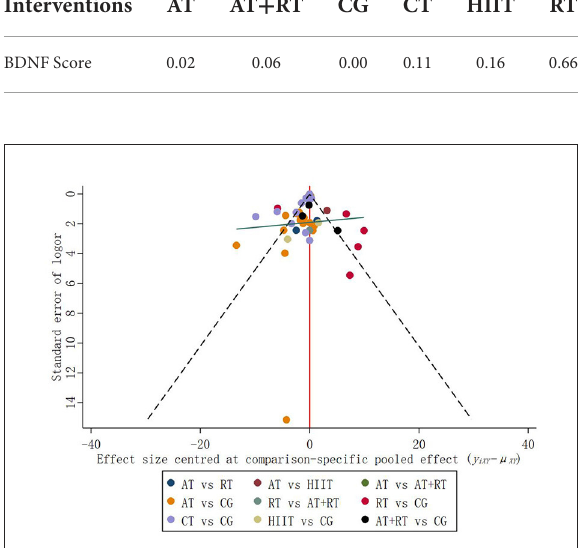
FIGURE5 Funnel plot of the effects of five exercise interventions on BDNF levels.